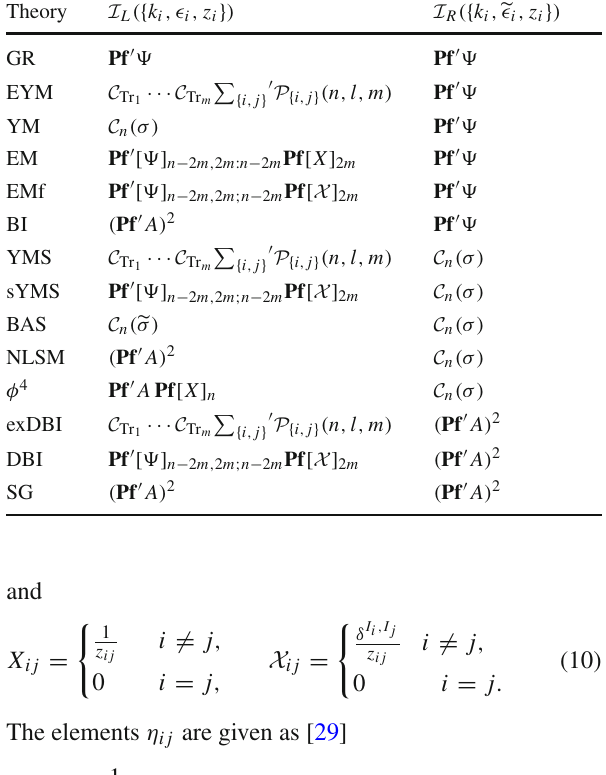
Table 1 Integrands for various theories